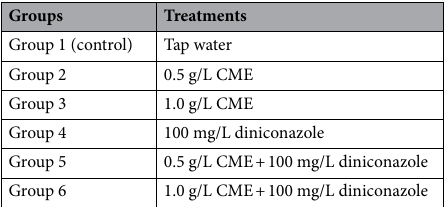
Table 1. Experimental layout of the